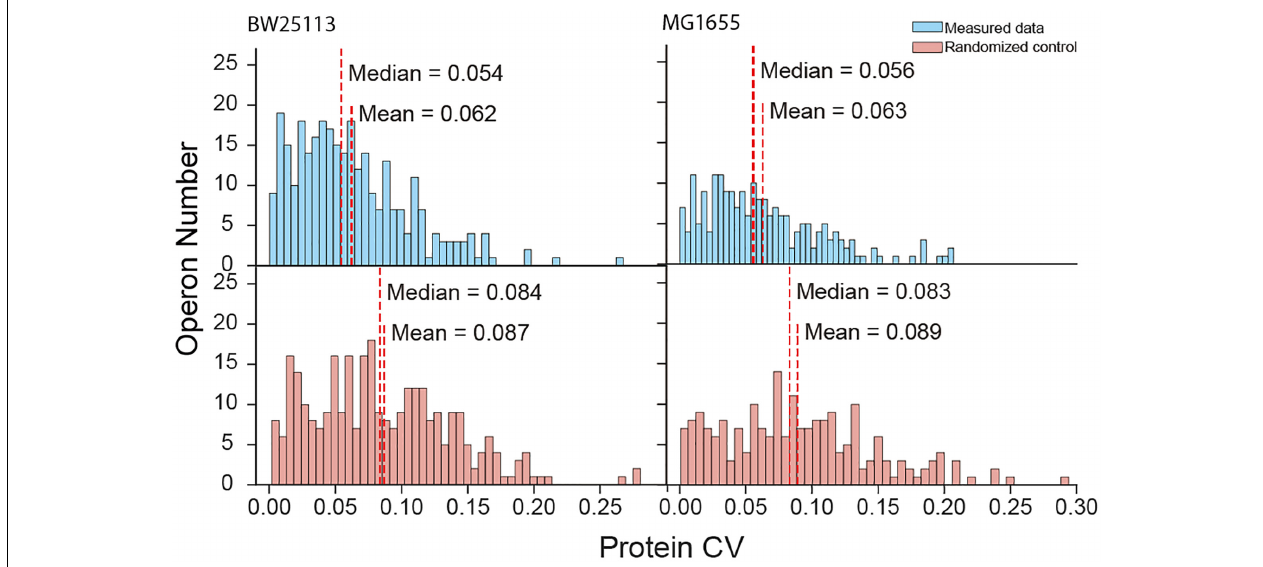
FIGURE 2 | Protein coefficient of variation (CV) within operons of measured data and randomized negative control.